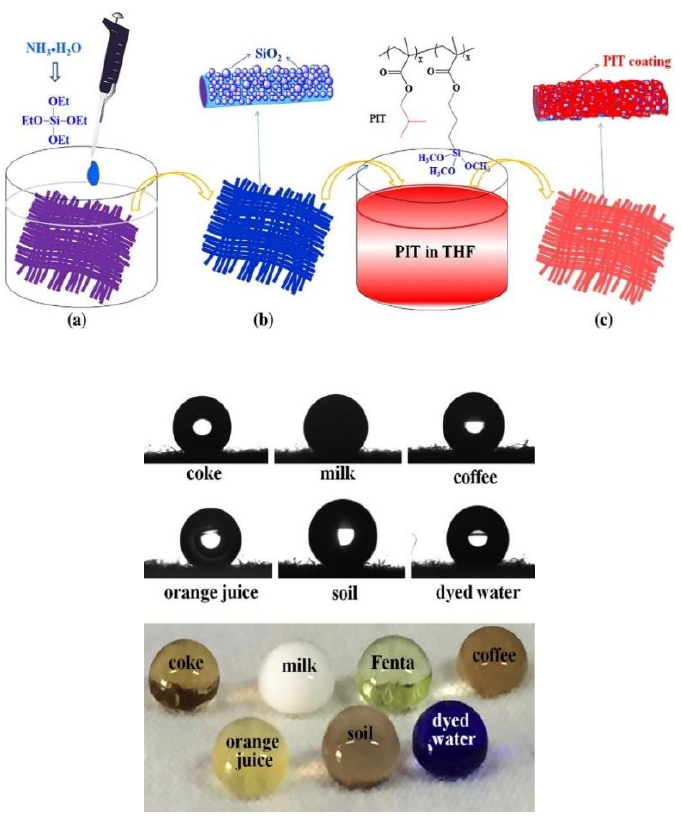
Figure 9. Hydrophobization of fabric with silica and polymeric water-repellent PIT. ( a ) Alkali-treated polyester fabric, ( b ) SiO 2 @fabric, and ( c ) PIT hydrophobized SiO 2 @fabric. The anti-stain properties of the fabric are observed upon trial with several aqueous mixtures ( bottom ). Reprinted with permission from ref. [124]. Copyright 2017 Elsevier.